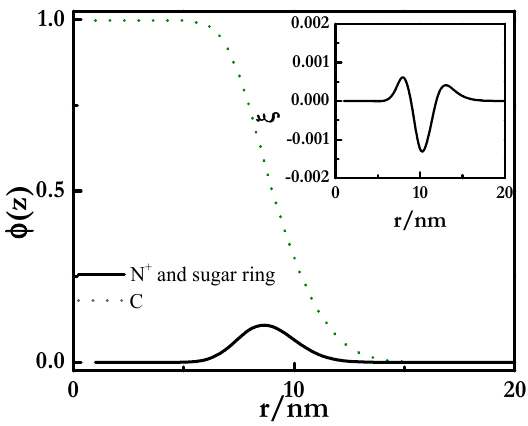
Figure 8. Dependences of the aggregation number of surfactants in the complexes ( g s , left axis) and the degree of polyelectrolyte–surfactant binding ( g PS , right axis) on μ P for mixtures of PDADMAC with di-RL.